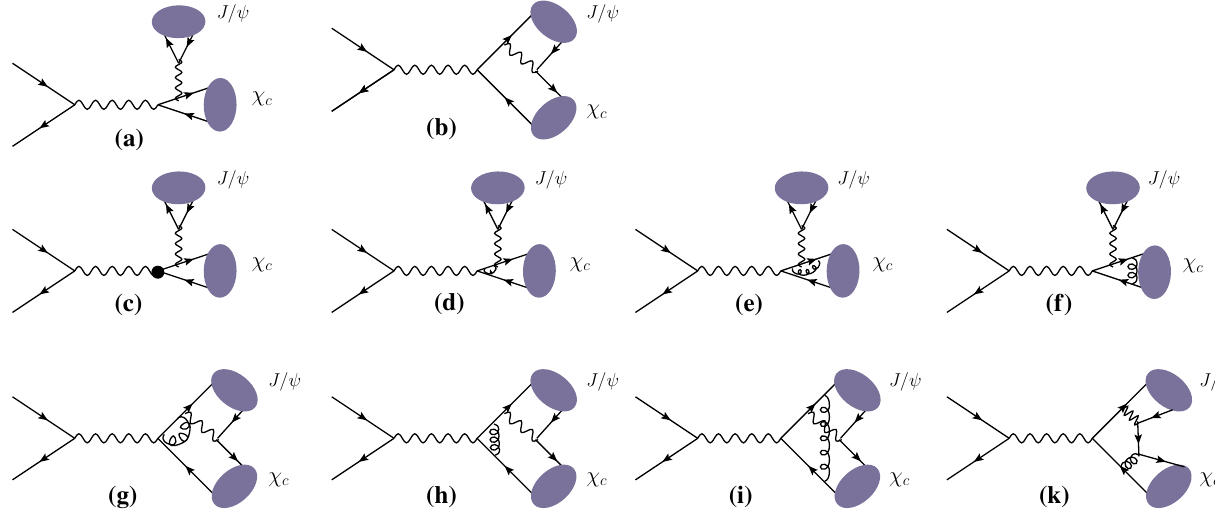
Fig. 1 Some sample QCD Feynman Diagrams for e + e − → J /ψ + χ c . a ( M αα corrections to a